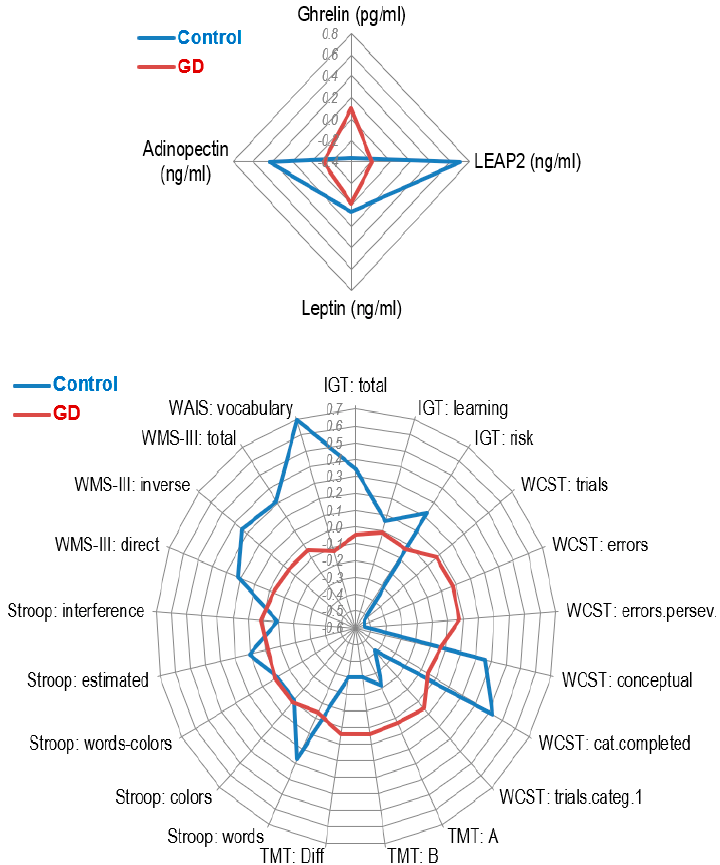
Figure 1. Radar-charts (z-standardized means are plotted). Note. GD: gambling disorder ( n = 297).